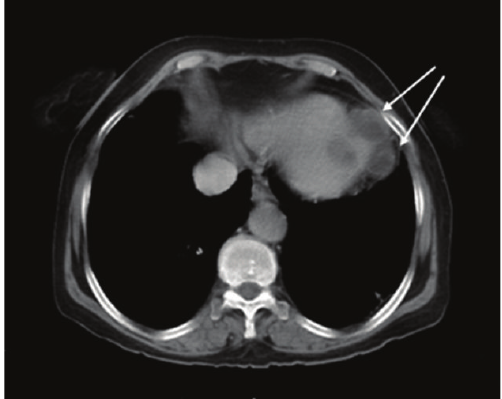
Figure 2: Computed tomography revealing multiple cystic echinococcosis . Multiple cysts surrounding apical region